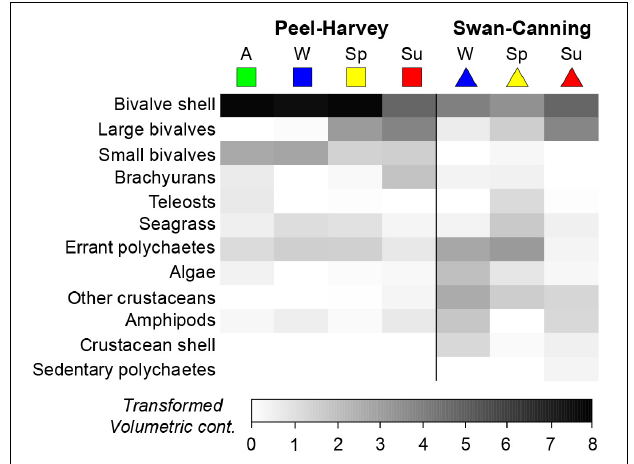
FIGURE 6 | Shade plot showing the square-root transformed volumetric contribution of the 12 most important dietary categories to the dietary composition of Portunus armatus in each Austral season in the Peel-Harvey and Swan-Canning estuaries. A = Autumn, W = Winter, Sp = Spring, Su = Summer.